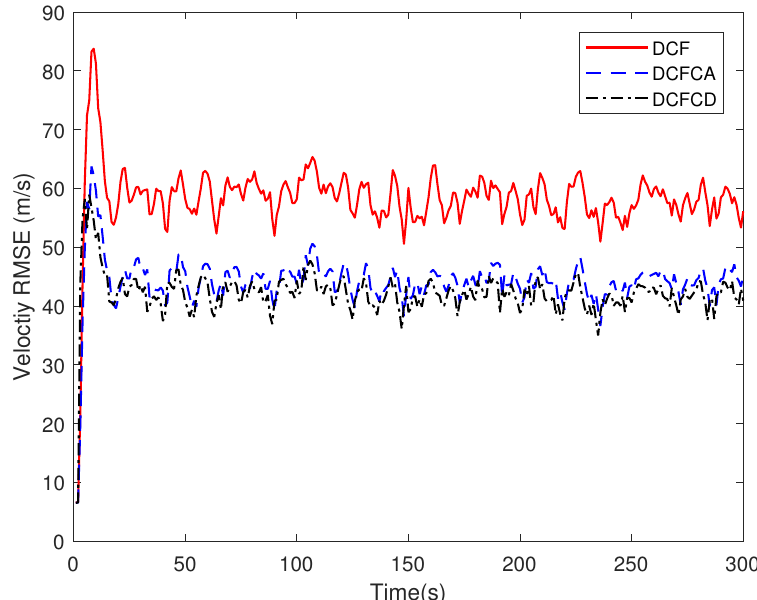
Figure 8. The velocity RMSE for different local filters of failure node without